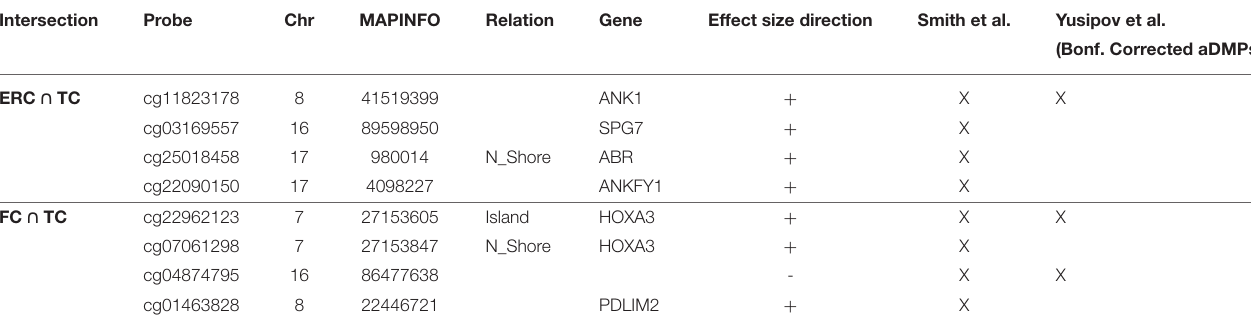
TABLE 6 | AD&aDMPs resulting from cross-region intersections.